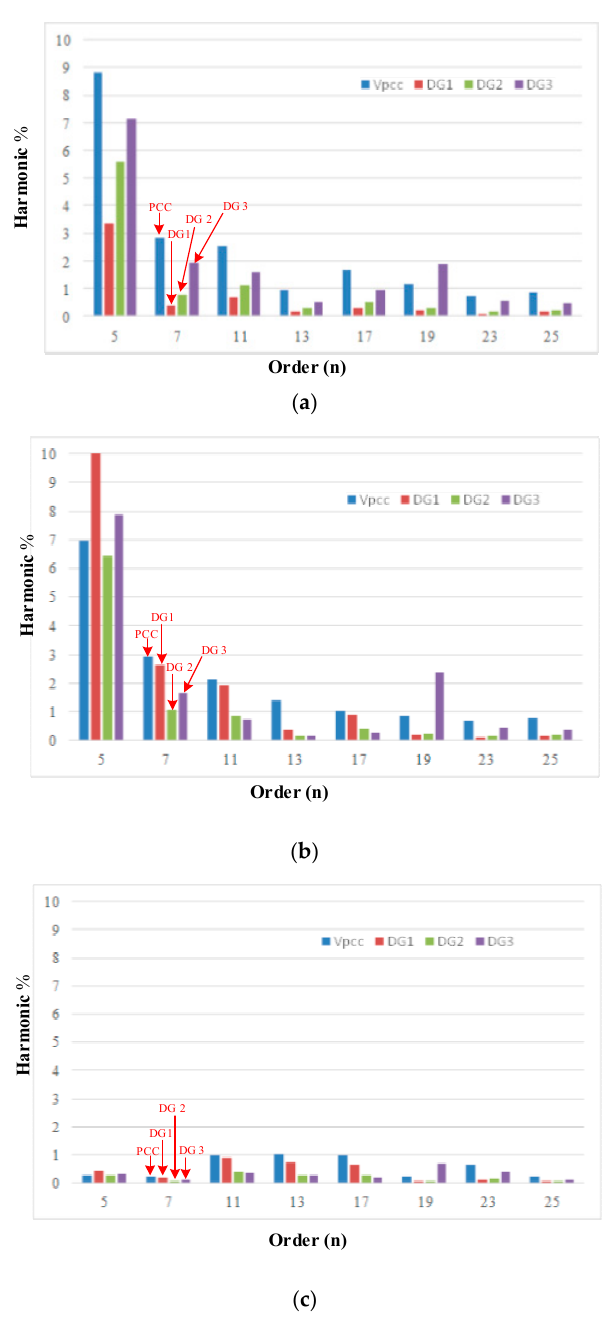
Figure 11. The frequency spectrum of PCC voltage and output DG voltages of multiple DGs under di ff erent steps with and without APF in an islanded microgrid. ( a ) First step (without harmonic current compensation); ( b ) second step (with harmonic current compensation); ( c ) third step (enabling the